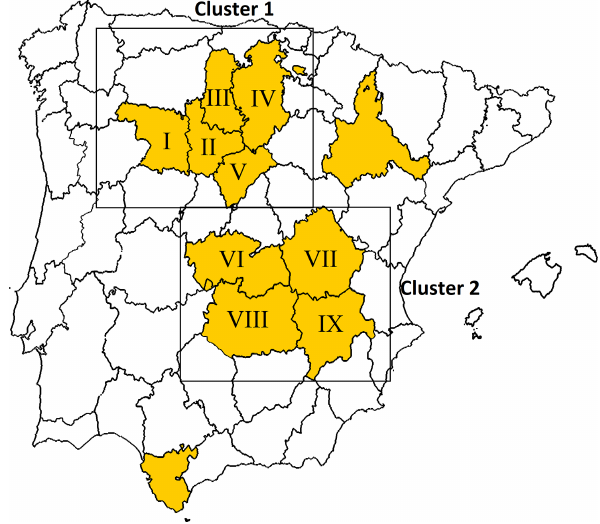
Figure 1. Provinces with more than 50% of the territory occupied by agricultural areas and more than 50% of rainfed crops (yel- low), according to CLC (2012), and selected clusters of provinces. Cluster 1 provinces: Zamora (I), Valladolid (II), Palencia (III), Burgos (IV) and Segovia (V). Cluster 2 provinces: Toledo (VI), Cuenca (VII), Ciudad Real (VIII) and Albacete